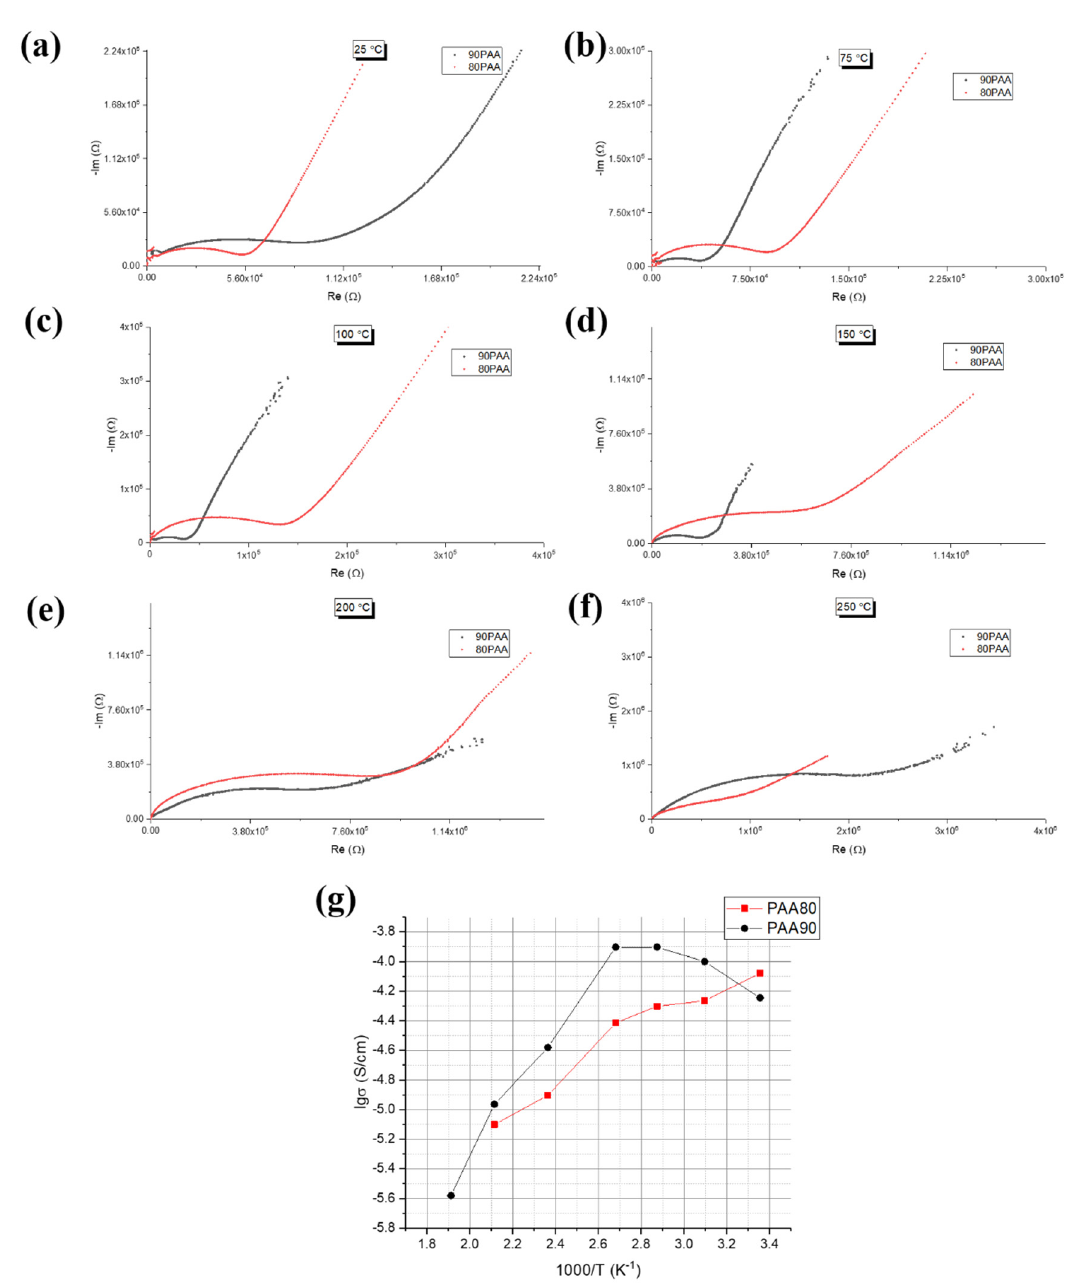
Figure 11. Electrical response comparison between the 10 wt.% and 20 wt.% binder content samples with temperature variation: ( a ) 25 °C; ( b ) 75 °C; ( c ) 100 °C; ( d ) 150 °C; ( e ) 200 °C; ( f ) 250 °C; ( g ) the Arrhenius plots obtained for grain boundary components of conductivity of the 90PAA and 80PAA samples.